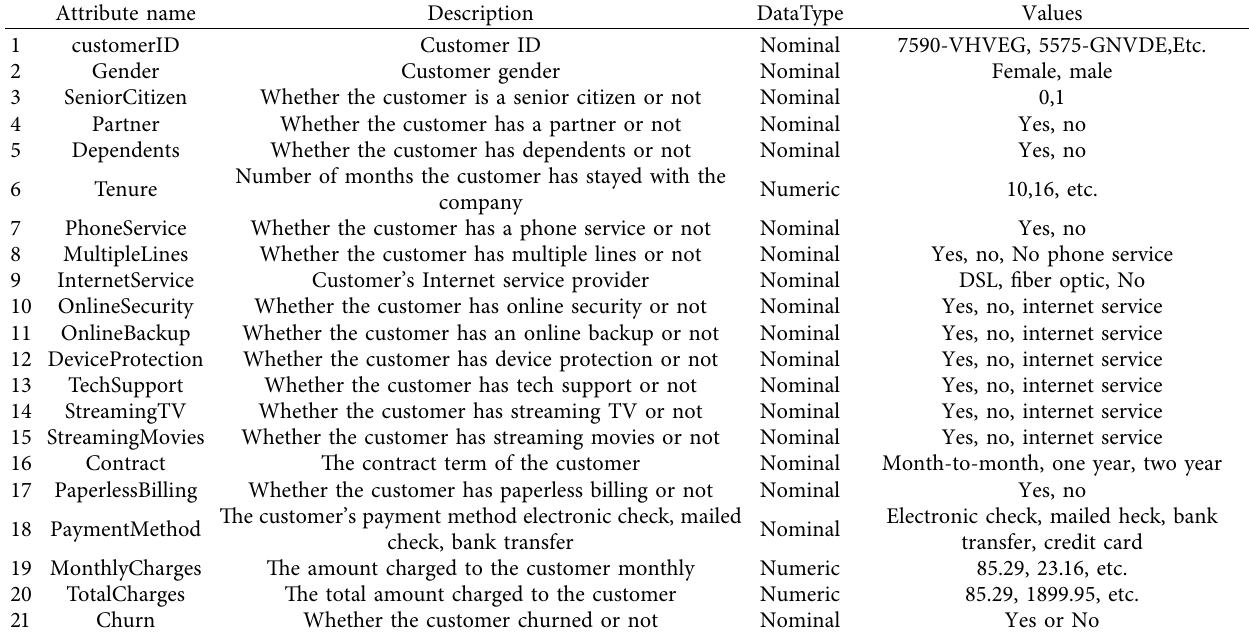
Table 2: Customer characteristics in the U.S. telecommunication company database (https://www.kaggle.com). Attribute